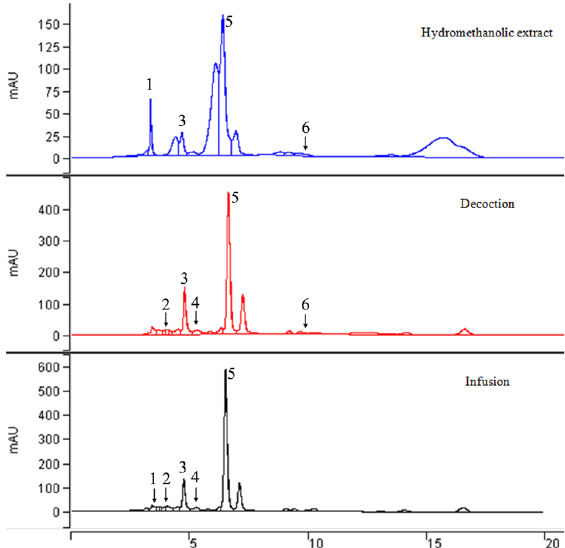
Figure 1 - Chromatogram obtained by RP-HPLC (330 nm) of phenolic compounds of hydromethanolic, decoction and infusion extracts from amoreira-preta leaves ( Morus nigra L.). Peaks: (1) quercetin, (2) rutin, (3) gallic acid, (4) catechin, (5) chlorogenic acid and (6) caffeic acid.